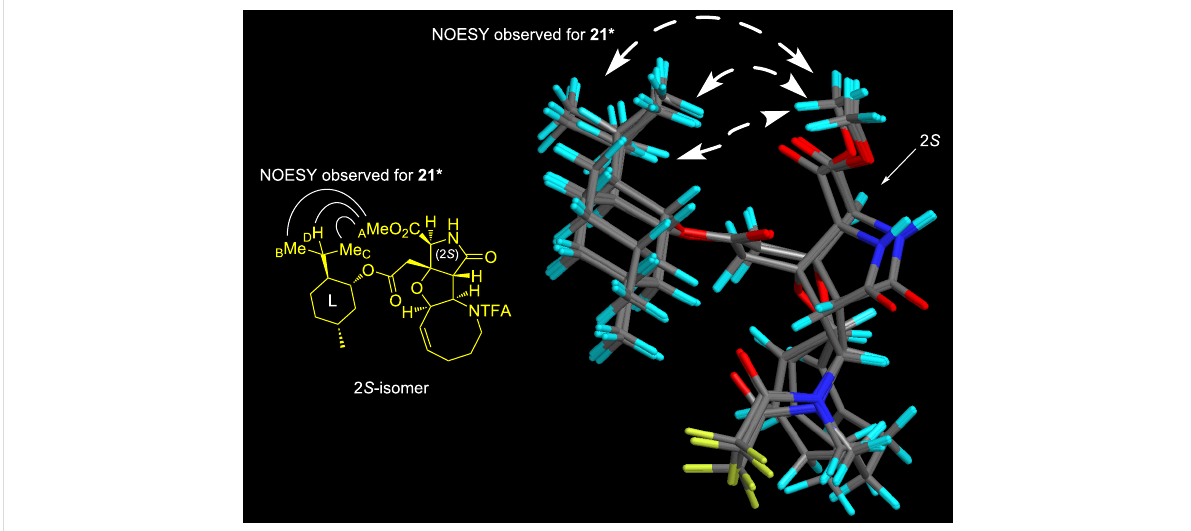
Figure 7: Superimposed structures of the top 5 stable conformers (89.9% total population) generated by CONFLEX (MMFF94S) for the (2 S )-isomer, which is consistent with the NOESY crosspeaks observed for 21* (400 MHz, CDCl 3 ). See Supporting Information File 5 for the stereo diagram.